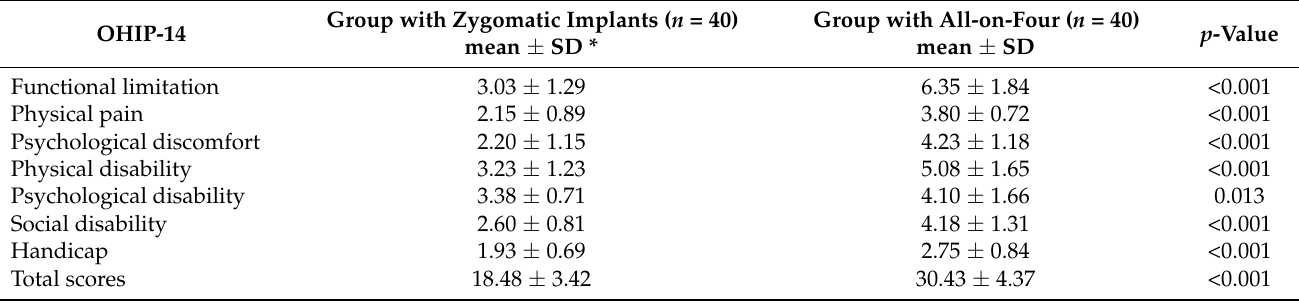
Table 4. Comparison of quality of life between study groups (Student’s t -test). OHIP-14